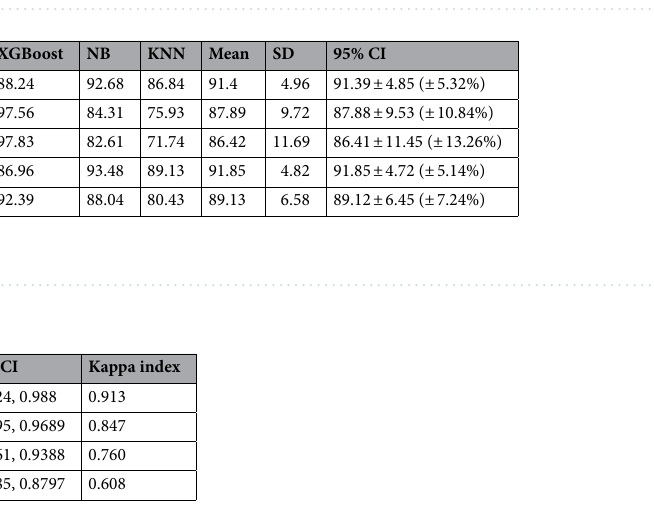
Table 4. AUROC and Kappa index for the earth fissure